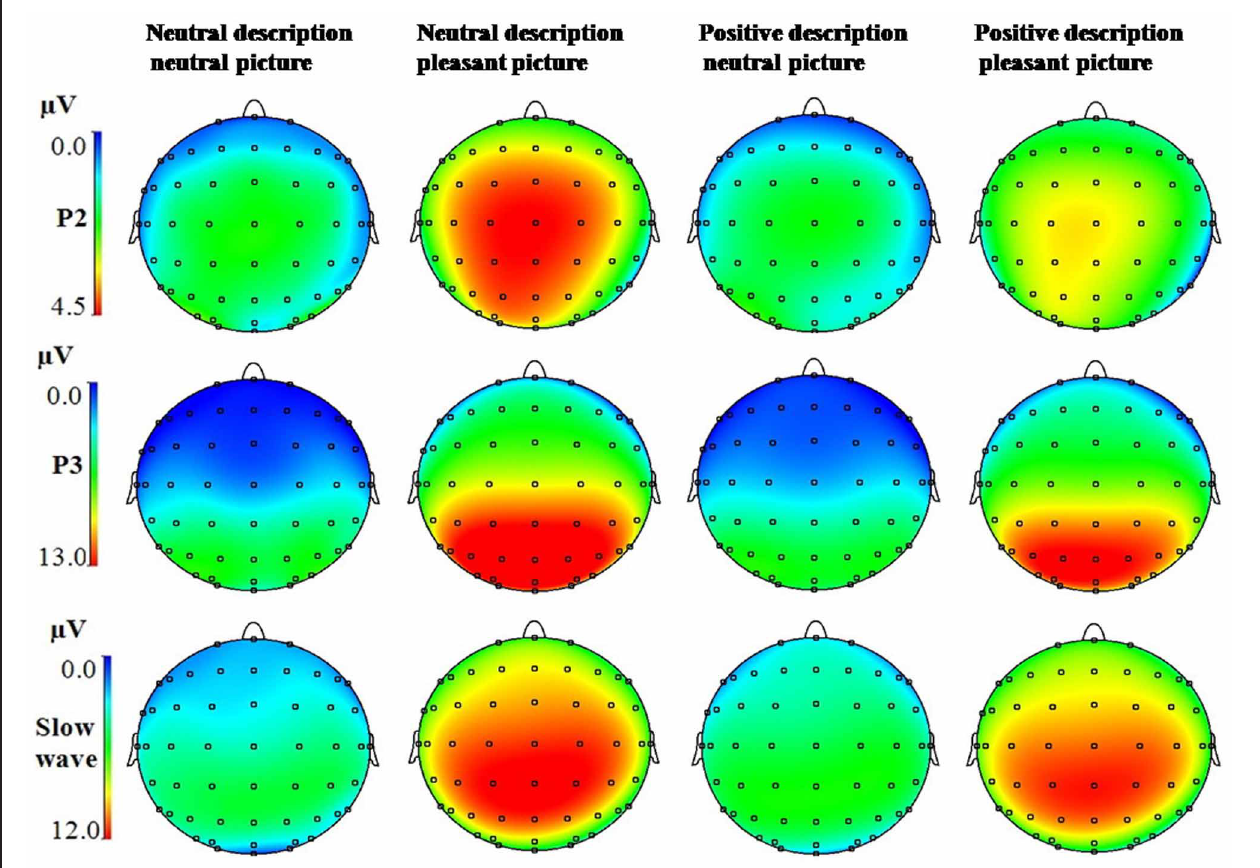
FIGURE 2 | The topographic map of the P2 (150–200 ms), P3 (330–400 ms) and slow wave (400–800 ms) components for the four